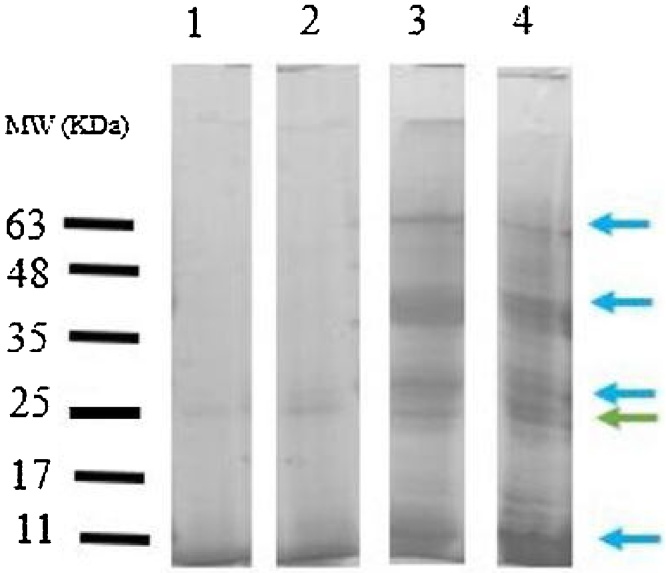
Evaluation of skin mucus protein profile using SDS-PAGE; The green arrow indicates band with enhanced intensity; the blue arrows indicate a new band; Line 1: station 1, Line 2: station 2, Line 3: station 3 and Line 4: station 4.